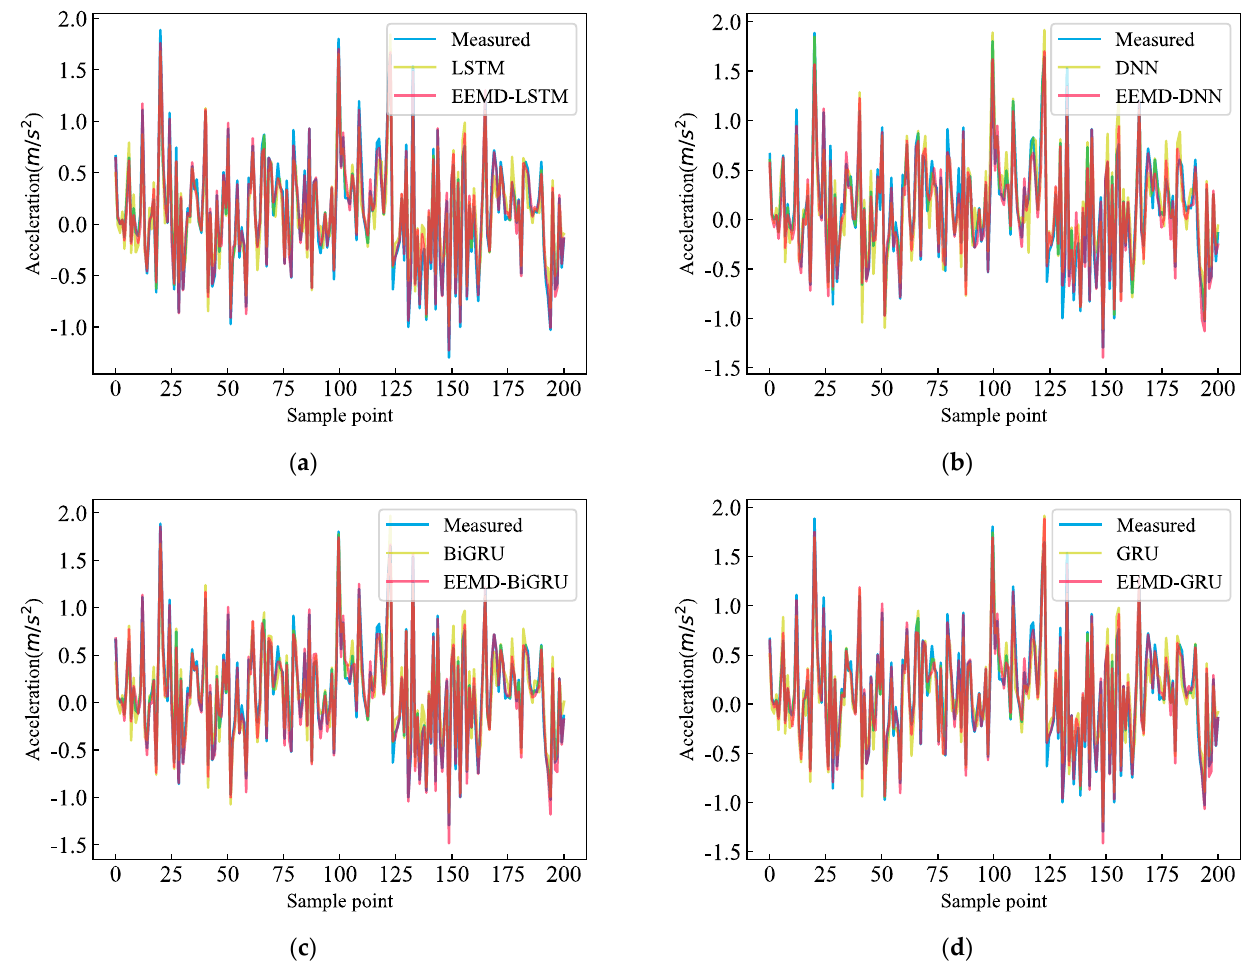
Figure 10. Prediction results of the traditional models and hybrid models: ( a ) comparison between LSTM and EEMD-LSTM (white dataset); ( b ) comparison between DNN and EEMD-DNN (white dataset); ( c ) comparison between BiGRU and EEMD-BiGRU (white dataset); ( d ) comparison between GRU and EEMD-GRU (white dataset).